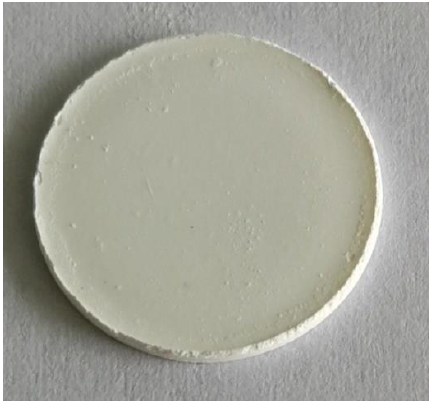
Figure 3. Superhydrophobic bulk material prepared by pelleting.